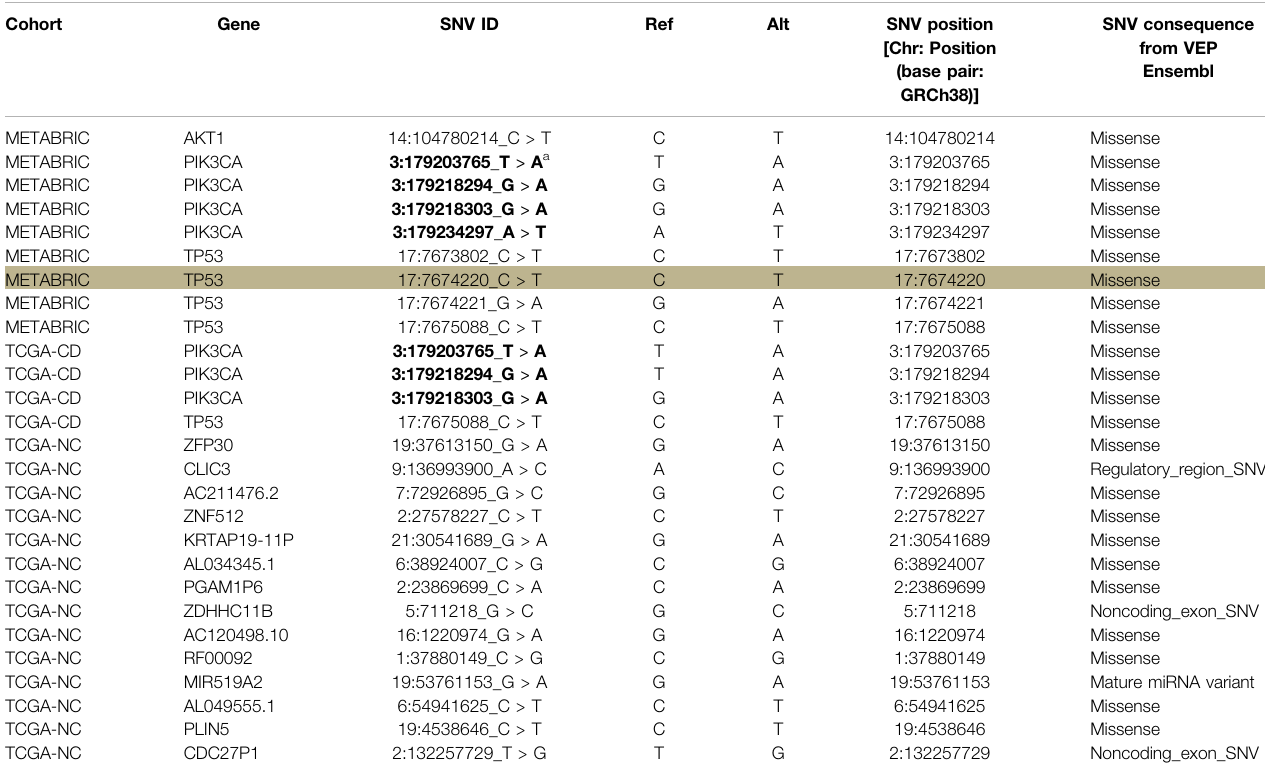
TABLE 3| Anoverview ofthegenesharboring therecurrent pathogenic SNVspredictedbyourmodels. The “ SNVID ” columnshows theIDoftherecurrent SNVthataffects the gene mentioned in “ Gene ” column. “ Ref ” column shows the nucleotide in the reference genome sequence and “ Alt ” column shows the alternative nucleotide that is substituted for the reference nucleotide. The highlighted row shows the SNV that appeared as signi fi cant through our subsequent survival analysis.